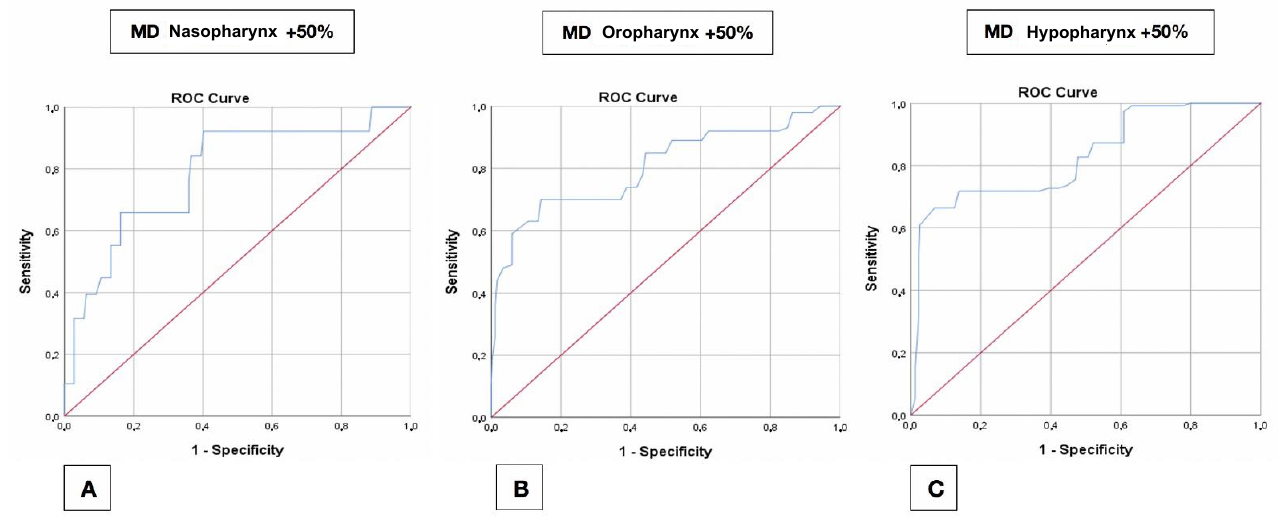
Figure 6. ROC curves relative to the +50% area increase; mandibular displacement for the three subregions analysed. ( a ) Nasopharynx. ( b ) Oropharynx. ( c ) Hypopharynx.